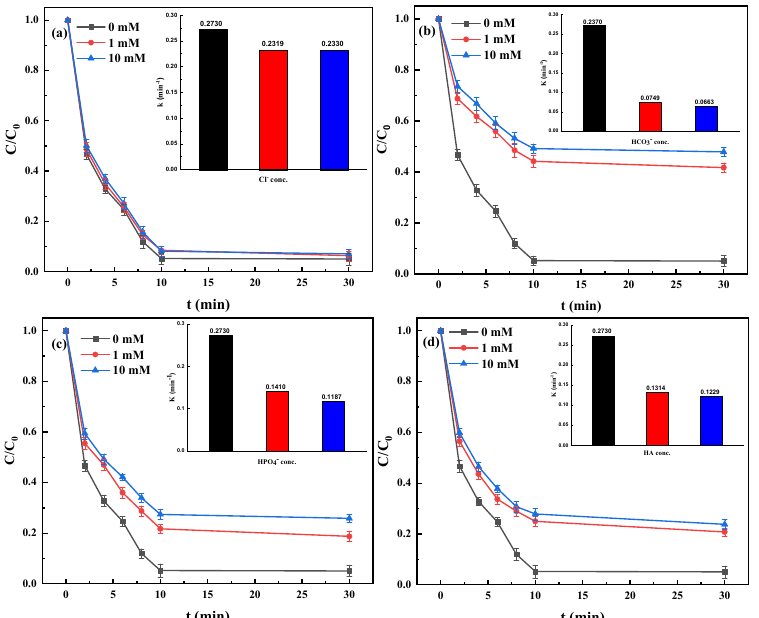
Figure 3. Effects of co-existing anions Cl − ( a ), HCO 3 − ( b ), H 2 PO 4 − ( c ), and HA ( d ) on TBBPA removal performance of Fe@MC/PS system. (Fe@MC dosage = 0.1 g·L − 1 ; [PS] = 1 mM; [TBBPA] = 10 mg·L − 1 and the internal illustrations show reaction rates under different conditions).